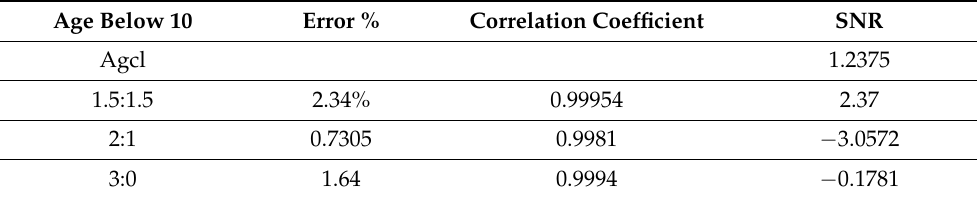
Table 1. Comparison of three different electrode concentrations based on age.